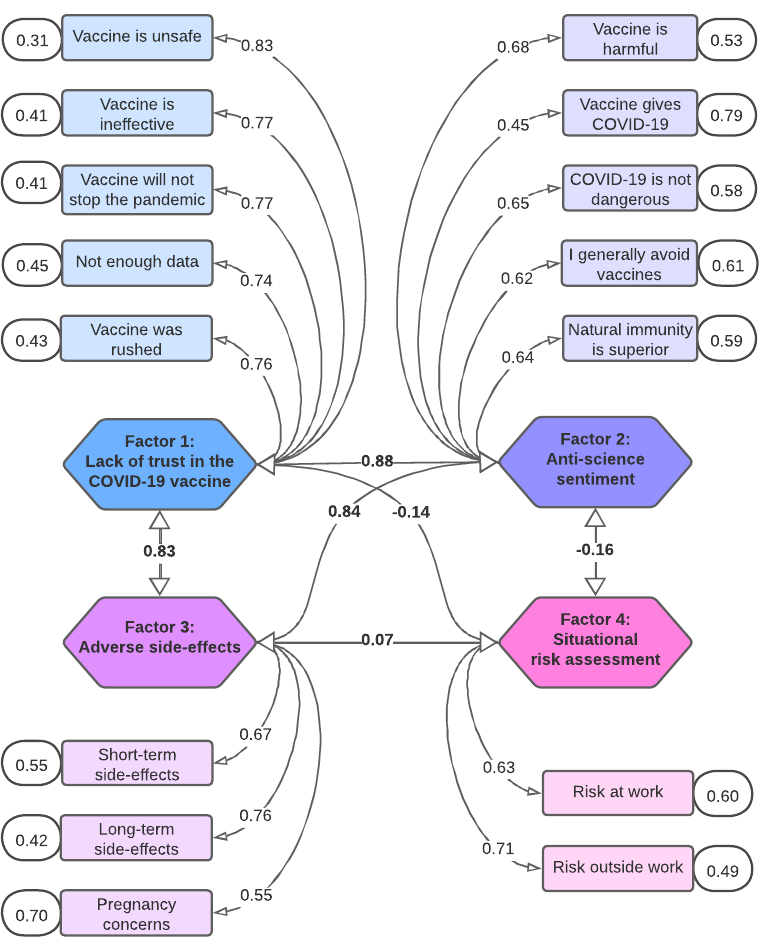
Figure 1. CFA Factor Diagram. Survey items mapped to the factors onto which they loaded most strongly in CFA. The hexagons in the center represent factors, with each arrow from factor to factor providing the standardized covariance (Pearson’s correlation, r) between those two factors. The rectangles represent survey items, with each arrow from factor to survey item providing the factor loading (correlation between factor and survey item) for the factor onto which that survey item loaded most strongly. The ovals in the outer margins next to the survey items provide the variance of each individual survey